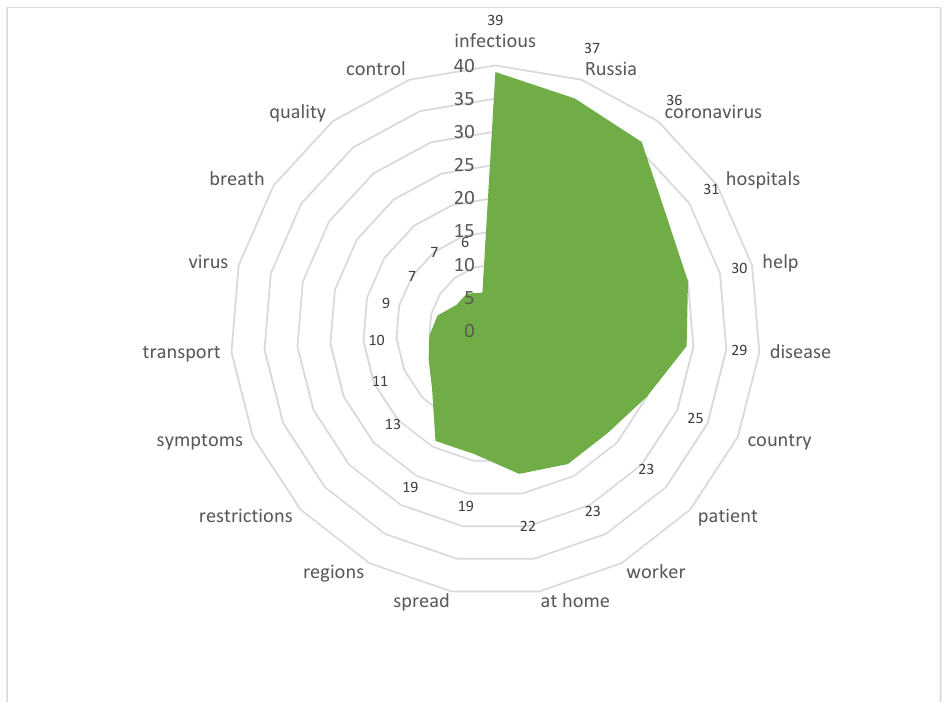
Figure 14. Associative network for stimulus online-medicine